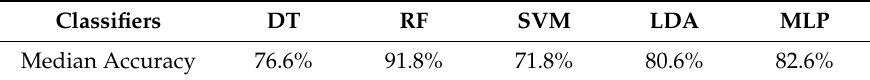
Table 7. Median classification accuracy according to the machine learning classifiers tested regardless of segmentation technique.